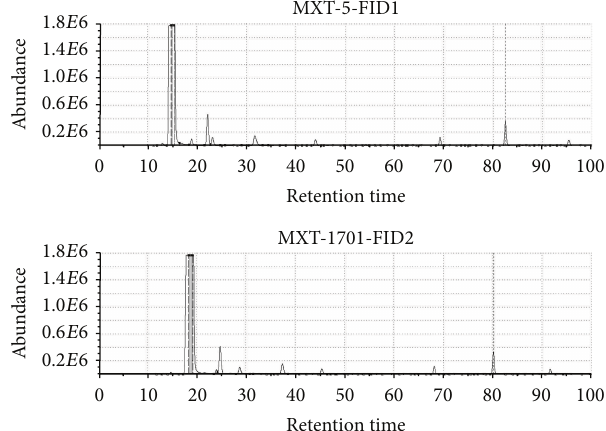
Figure 12: An example of a whisky sample presented in a chro-